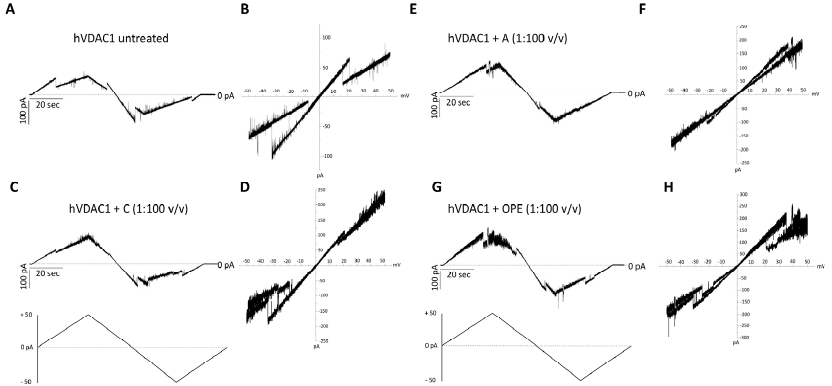
Figure 2. Analysis of hVDAC1 voltage dependence following the addition of the tested com-pounds by triangular voltage ramps. Sample A (panels ( E , F )), sample C (panels ( C , D )) and sample OPE (panels ( G ) and ( H )) were added to both sides of a DiPhPC bilayer containing hVDAC1 at a final concentration of 1:100 ( v / v ) and compare with the control (panels ( A ) and ( B )). Current measurements were performed in symmetrical 1 M KCl upon application of a triangular voltage ramp of ±50 mV. The corresponding I–V plots were obtained by plotting the current as a function of clamp voltage.